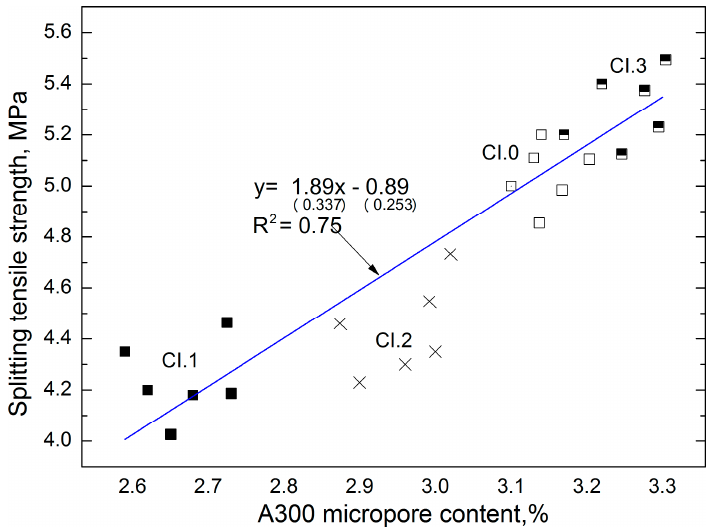
Figure 6. Dependence of splitting tensile strength of CI concrete on A300 micropore content.